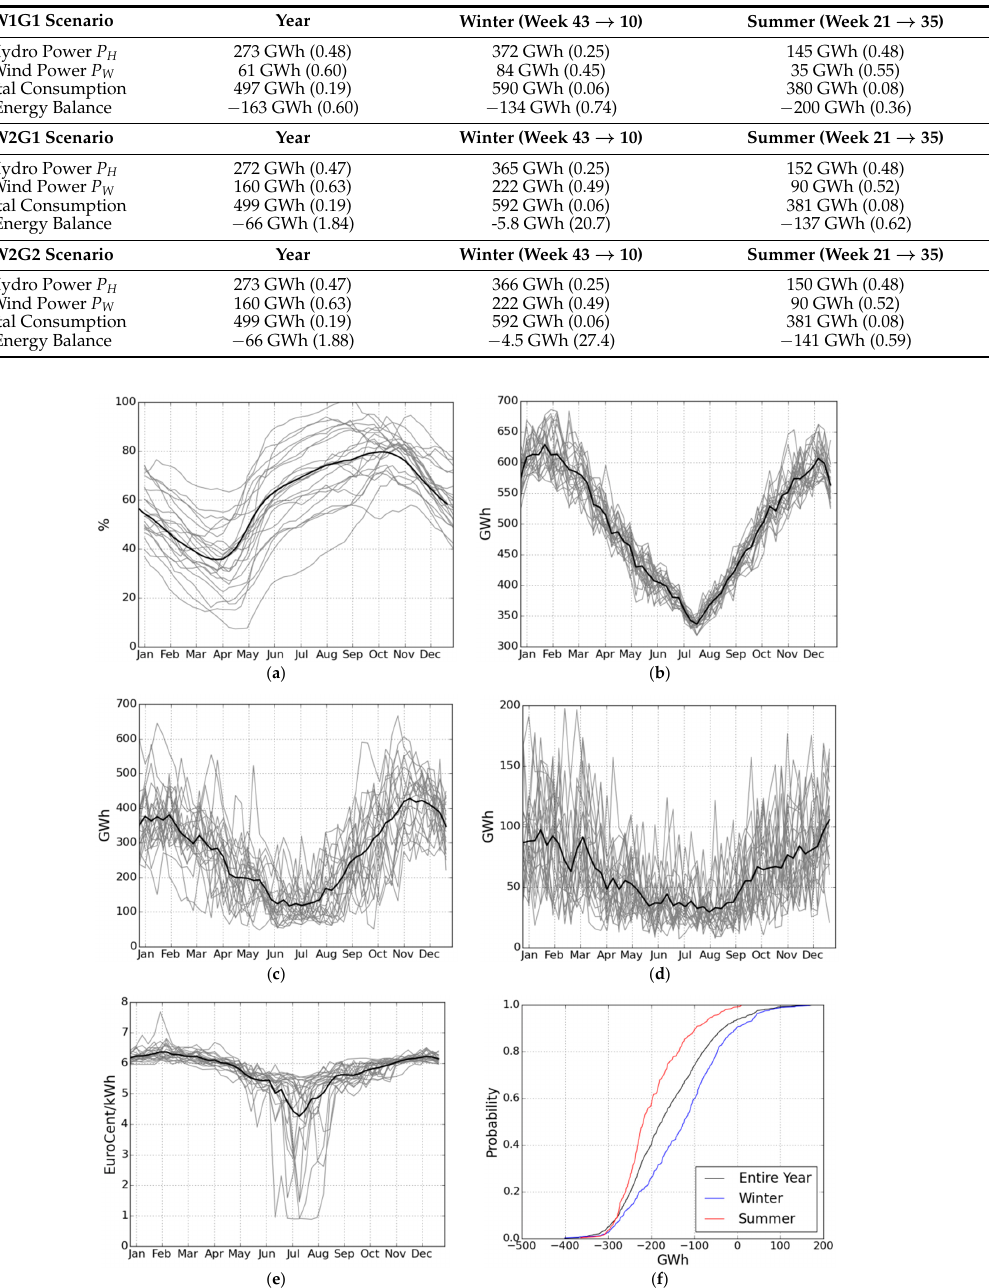
Figure 3. Weekly: ( a ) Aggregated energy storage expressed as ratio of the total storage capacity; ( b ) total electricity consumption (i.e., temperature and price dependent consumptions); ( c ) hydropower (from regulated + unregulated power plants); ( d ) wind power generation; and ( e ) electricity prices time series in Mid-Norway for the period 1961–1982. Note that only the fraction of electricity consumption temperature dependent is plotted. Grey curves represent week-to-week values for each year and the black curve represents the average annual cycle; ( f ) Cumulative distribution function of Mid-Norway weekly energy balance. Winter season is defined as from Week 43 to Week 10 of the following year and summer season from Week 21 to Week 35. As a result of the deficit, Mid-Norway imports electricity from the regions of Inndalselven and Helgeland over, respectively, 90% and 70% of the weeks (Figure 4). Meanwhile, the region exports electricity to East-Norway 90% of the time. The line between Mid- and West-Norway is used for both importing and exporting electricity. Note that 20% of the weeks the transmission line is not used at all (Figure 4). Similar distributions are obtained during winter season. Note that these simulated results are consistent with the current deficit and exchange situation of the region as presented in the previous sections.